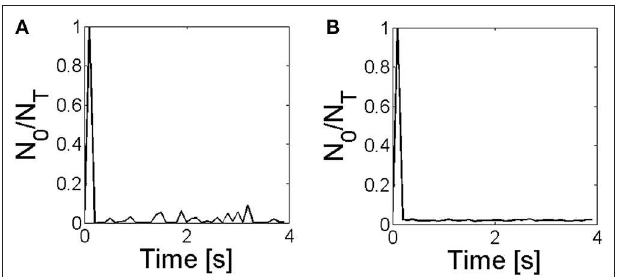
FIGURE 11 | Fraction of IP 3 Rs that participate of a global Ca 2 + release event, N o / N T , derived from stochastic simulations of the model described in section 2.4 with a mean separation between clusters of 0.4 µ m and δ Ca 200 s − 1 (A) and δ Ca 20 s − 1 (B) , it is conditions S3 and S4 of = = Table 3 ,